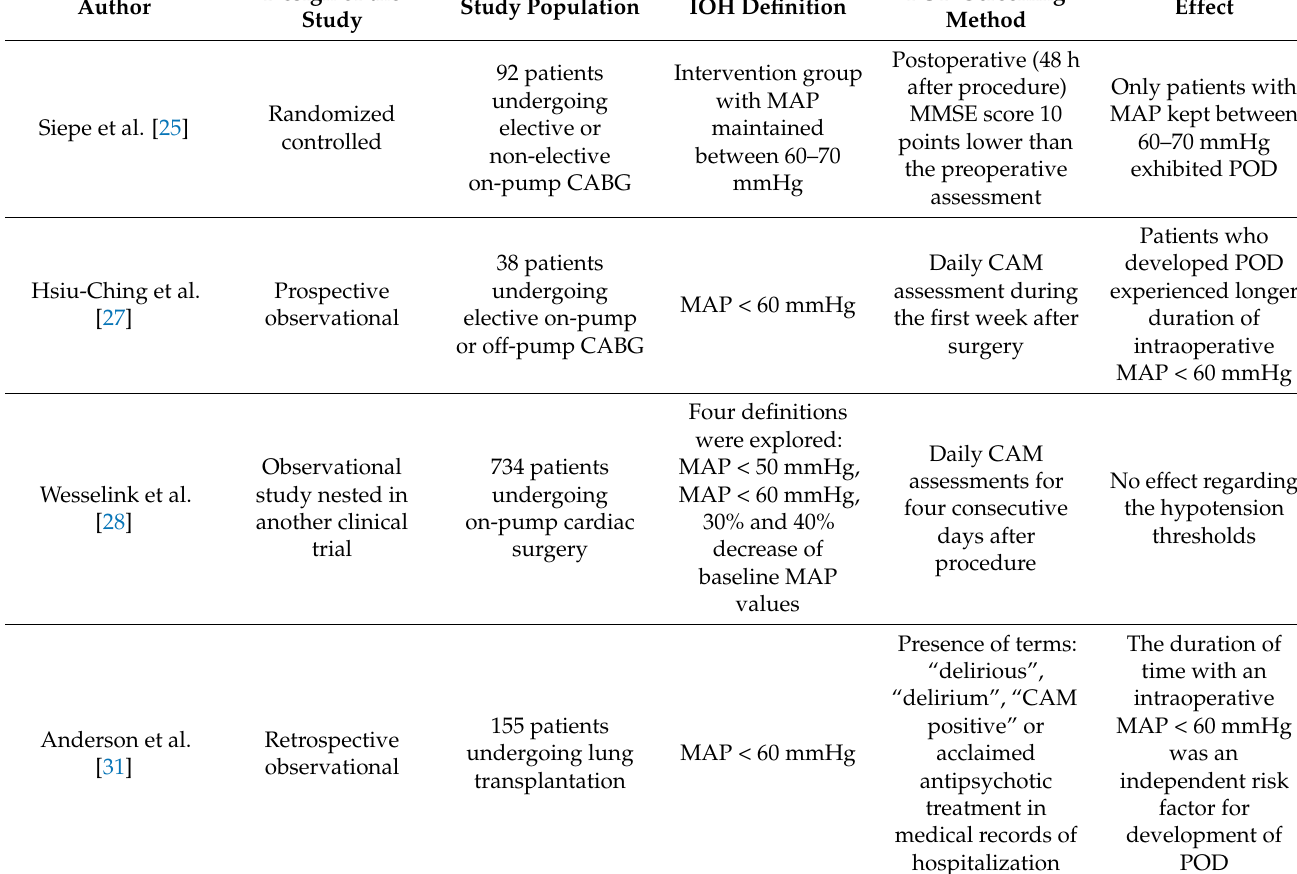
Table 2. Summary of studies on the association between intraoperative hypotension (IOH) or intraoperative blood pressure drop in cardiac surgery and postoperative cognitive delirium